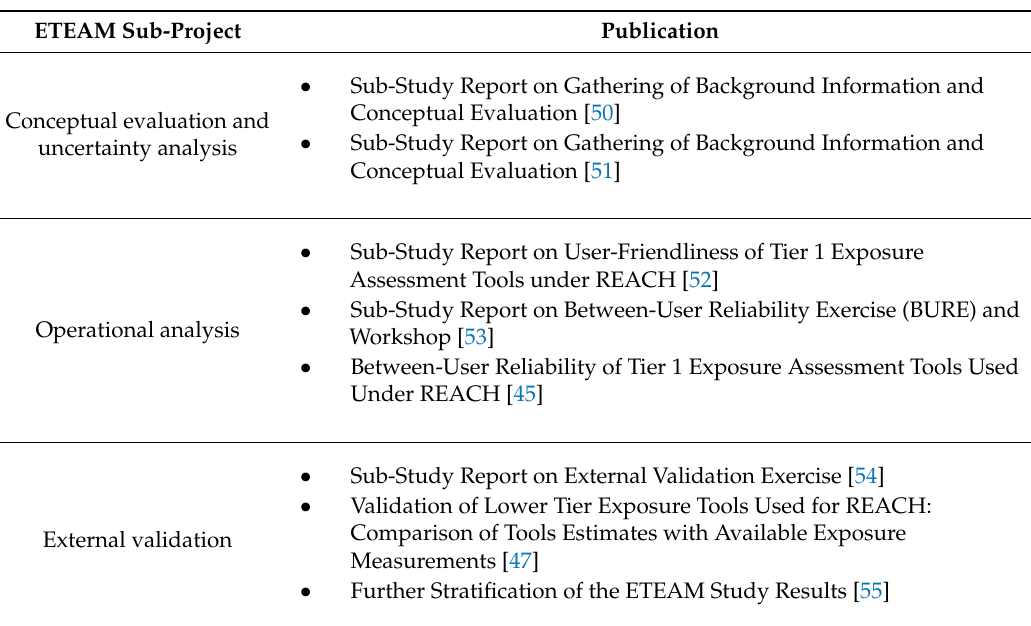
Table 1. Compilation of study reports and publications of the Evaluation of the Tier 1 Exposure Assessment Models (ETEAM)